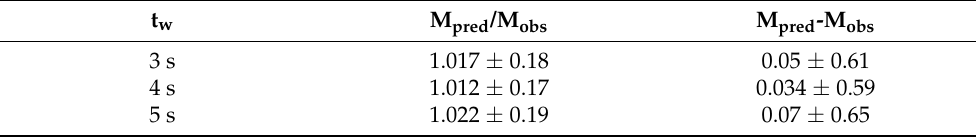
Table 1. The average values of ration M pred /M obs and the deviation M pred -M obs for the t w